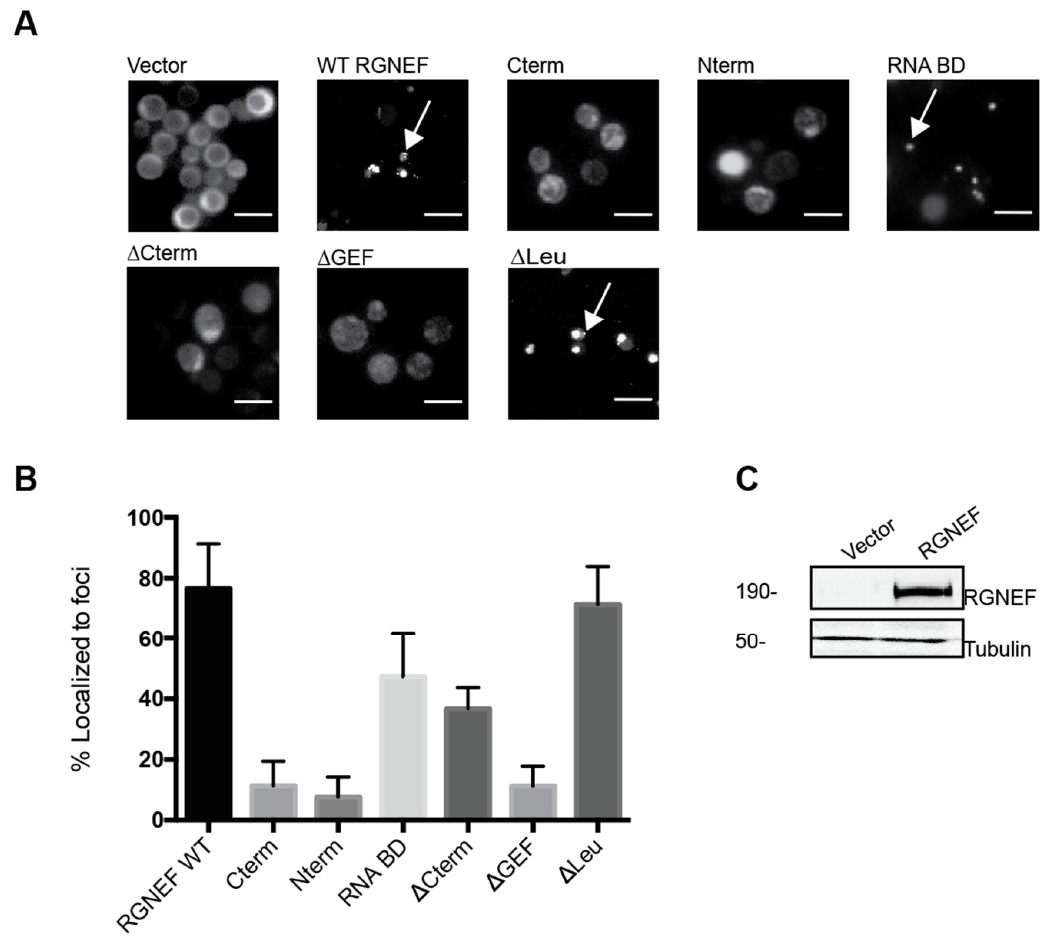
Figure 2. RGNEF-YFP localization in yeast. ( A ) RGNEF-YFP (wild type full length and truncated variants) localization and inclusion formation was observed using fluorescence microscopy in live yeast cells. Arrows indicate inclusions. The scale bar corresponds to 10 μm ( B ) Bar graph represents the quantification of data as shown in A as percentile of cell containing inclusions. ( C ) RGNEF expression is shown by Western blot analysis. Error bars represent standard deviations.